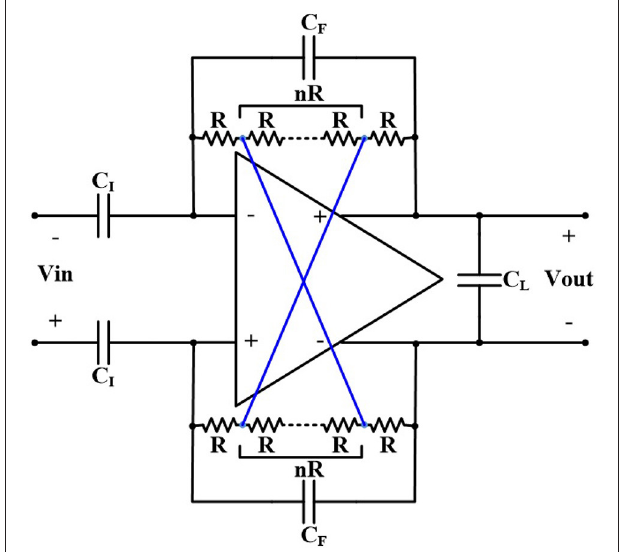
FIGURE 5 | The neural amplifier with cross-coupled positive feedback architecture.